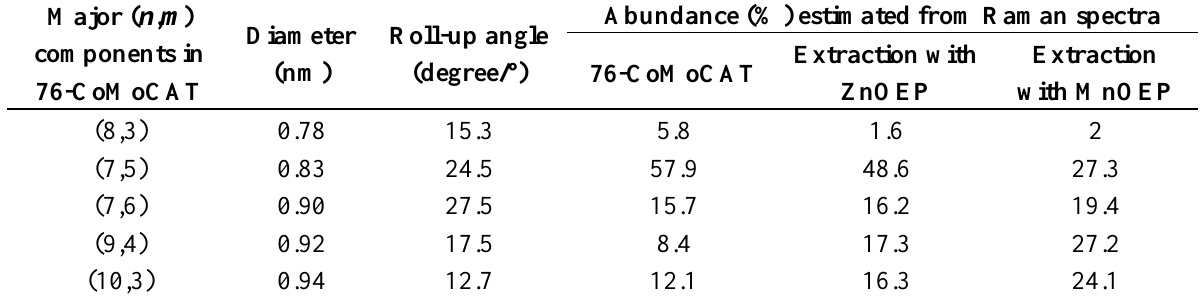
Table 2. The relative content of semiconducting SWNTs based on Raman intensity before and after the extraction of 76-CoMoCAT with ZnOEP and